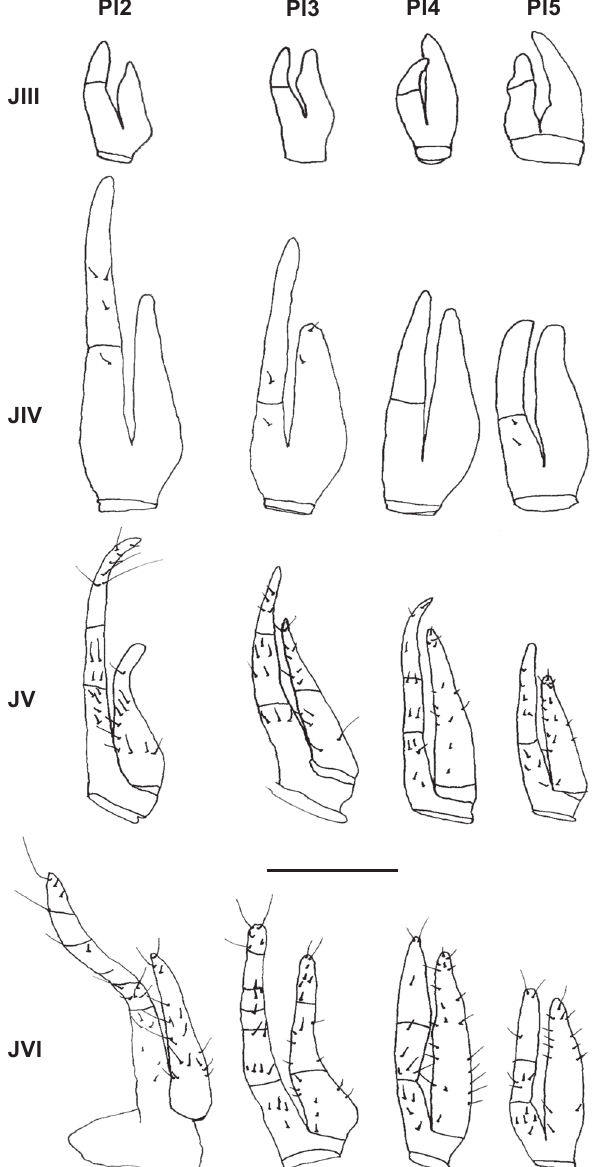
Figure 32. Pachygrapsus gracilis , juvenile instars. Female pleopods (Pl2-Pl5) from juvenile instar III to VI. Scale bar: JIII-JIV = 0.01 mm; JV-JVI = 0.02